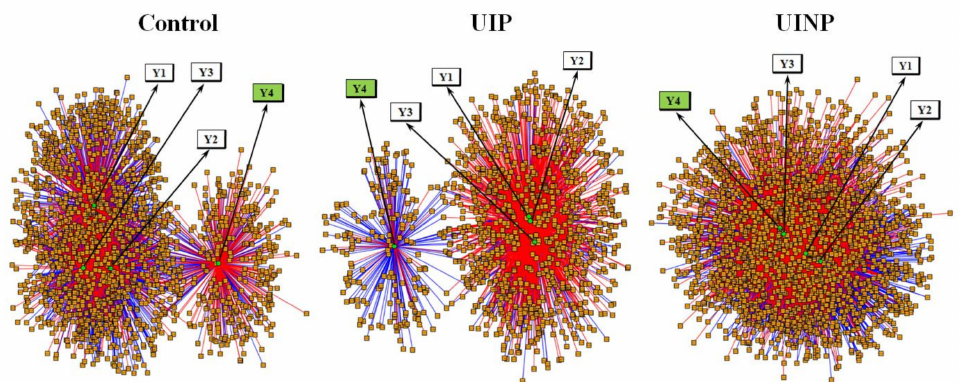
Figure 2. Integrative and differential network analysis between metabolic profiles and anthropomet- rical data/FMP ratio in Control, UIP, and UINP. Control: control group; UIP: urinary incontinence with Pilates; UINP: urinary incontinence with no Pilates; Y1: body mass; Y2: BMI; Y3: body fat percentage; Y4: FMP ratio; green circular node: anthropometrical data and FMP ratio (Y1, Y2, Y3, and Y4); orange squared node: metabolic profiles; blue edge: negative correlation between node variables; red edge: positive correlation between node variables.